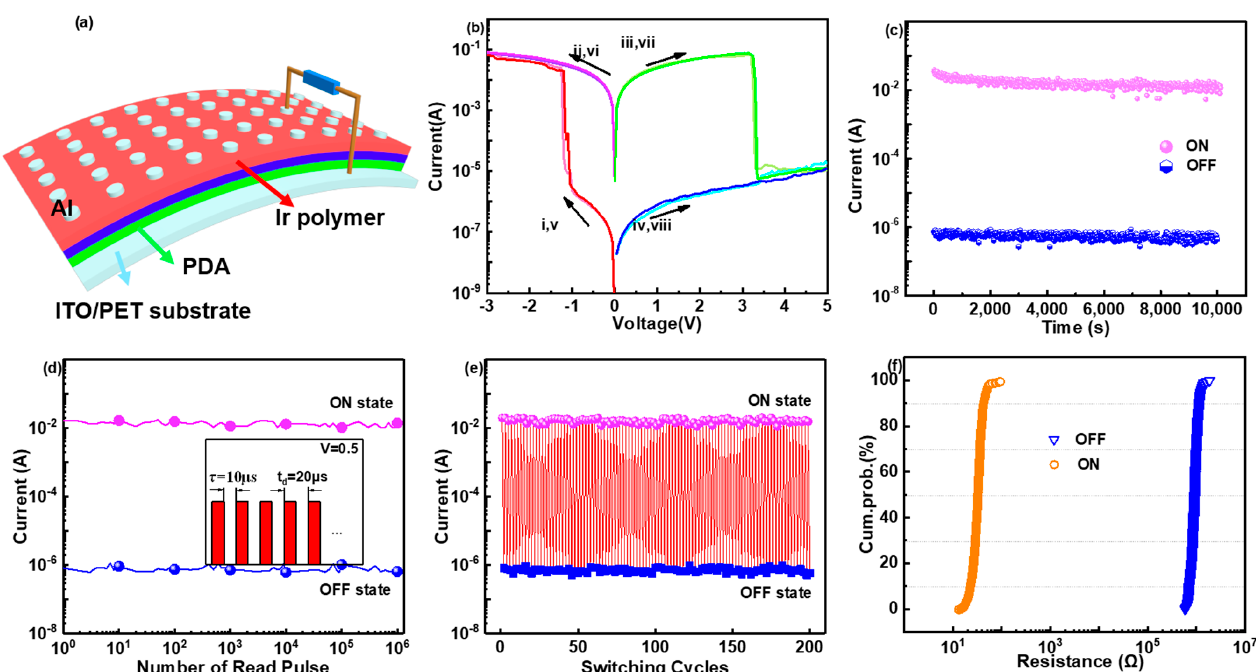
Figure 3. ( a ) Schematic illustration of Al/PDA-PPy 3 Ir/ITO device; ( b ) I-V curves of the device; ( c ) e ff ect of operating time on di ff erent state currents with an applied voltage of − 0.5 V; ( d ) effect of the read pulses with an applied voltage of − 0.5 V (pulse period = 20 μ s, width = 10 μ s) at di ff erent states; ( e ) endurance performances of the device (read at − 0.5 V, with the switched pulses of − 3 V and 5 V; pulse width: 100 ms; pulse period: 200 ms); ( f ) cumulative probability plots of the ON and OFF states. The resistances are acquired at − 0.5 V.